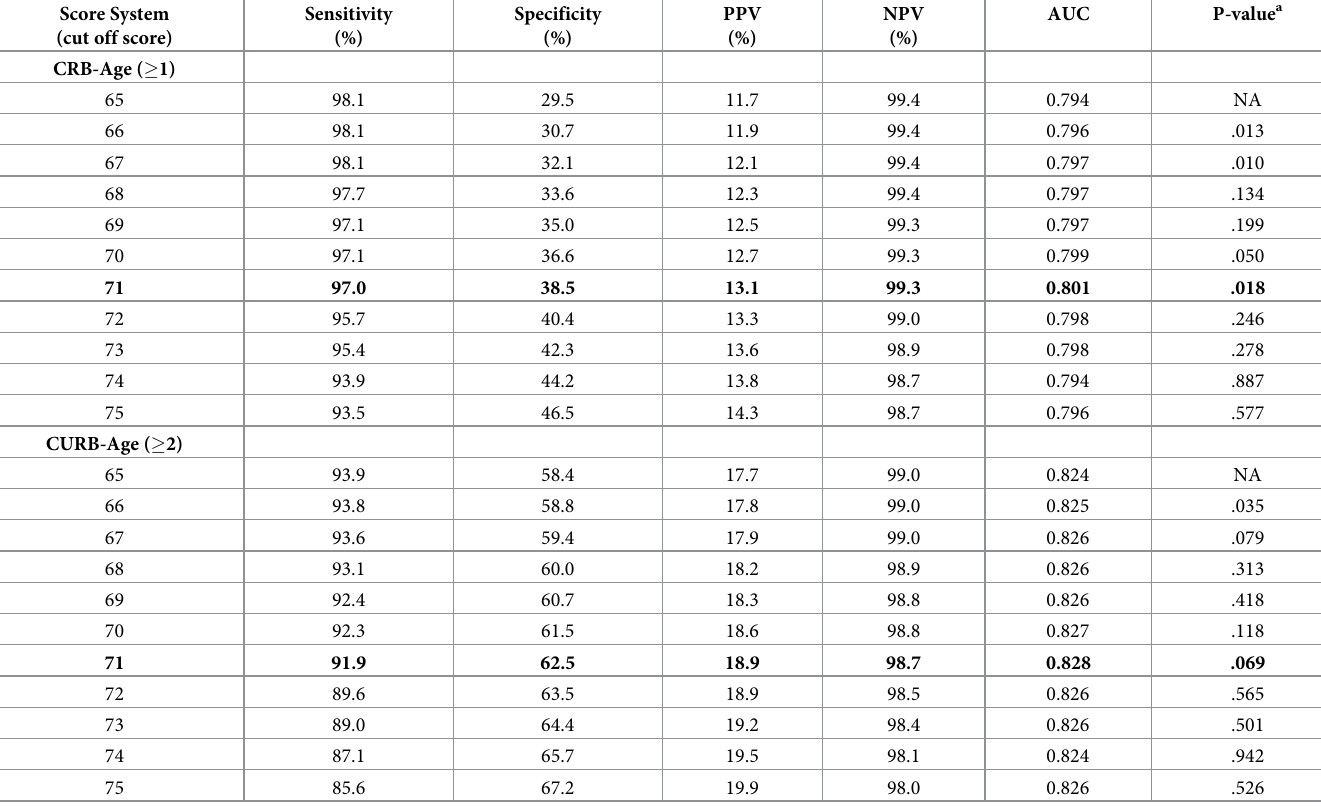
Table 2. Performance changes of CRB65 and CURB65 with increasing age in SNUBH-EDP